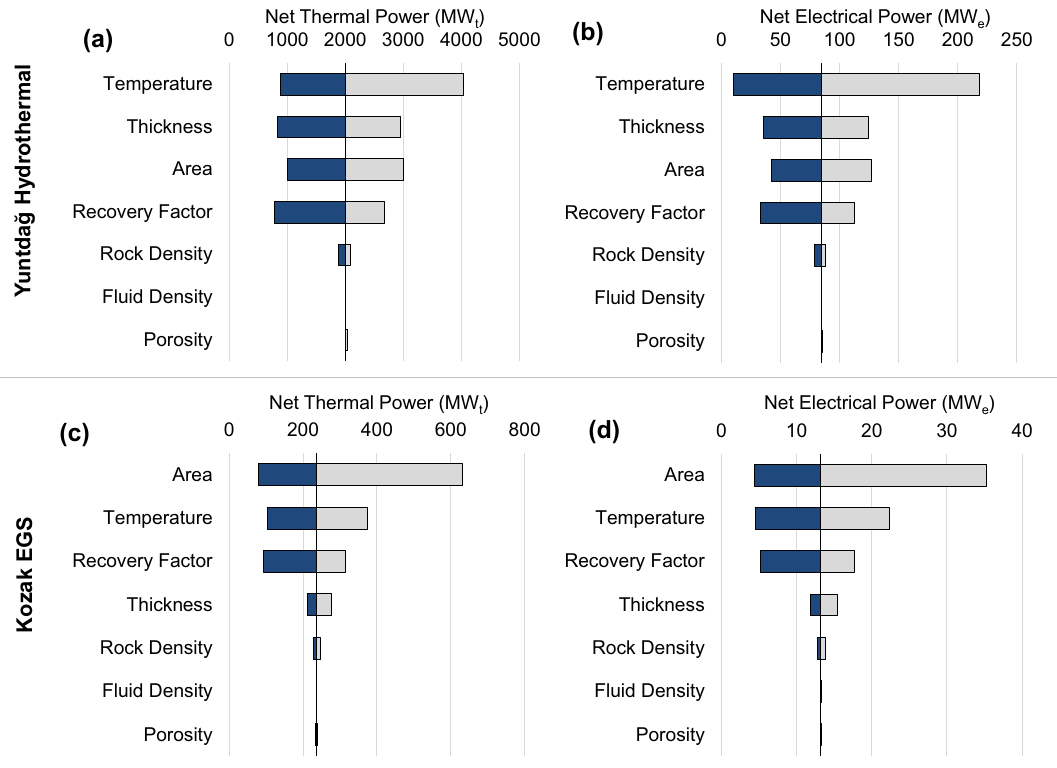
Fig. 10 Tornado charts that show the sensitivity to input parameters: a Yuntdağ hydrothermal direct utilization, b Yuntdağ hydrothermal indirect utilization, c Kozak EGS direct utilization, d Kozak EGS indirect